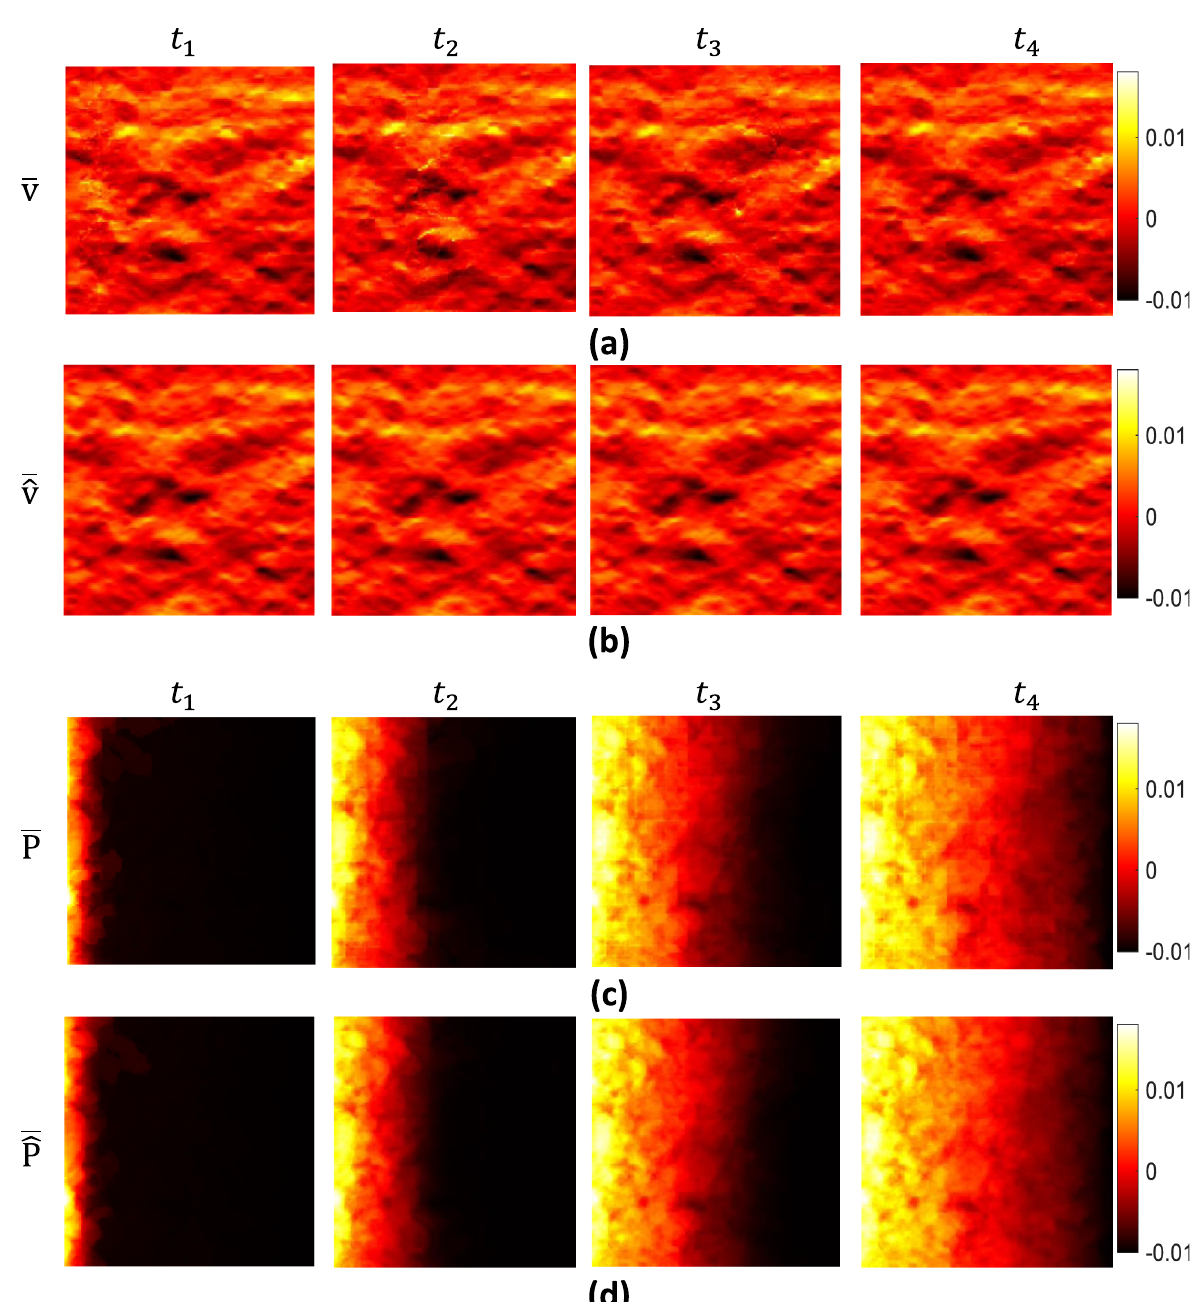
Fig. 6 Overall prediction accuracy of the PIRED. Comparison of the actual ensemble-averaged of ( a ) fl uid velocities v and ( c ) the fl uid pressure P with those predicted by the PIRED ( b ) and ( d ) for ^ v and ^ P in the polymeric network at four (dimensionless)